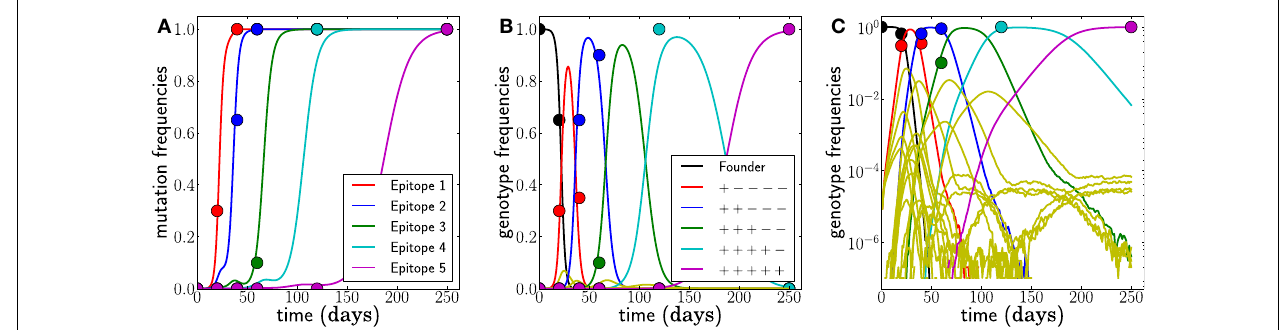
FIGURE 2 | Example of simulated escape mutations spreading through the population . (A) Even though all epitopes are targeted from t = 0, escape mutations spread sequentially.The mutation frequency in a sample of size 20 at different time points is indicated by colored dots. (B) The rising mutation frequencies are associated with the rise and fall of multi-locus genotypes.The founder virus is first replaced by a dominant single mutant, which itself is replaced by a double mutant and so